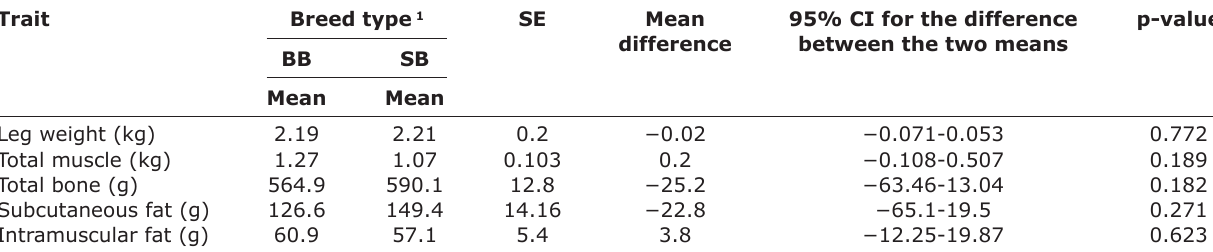
Table-5: Means, SD, and 95% CI for the difference between the means for leg cut of BB and SB kids. Trait 95% CI for the difference